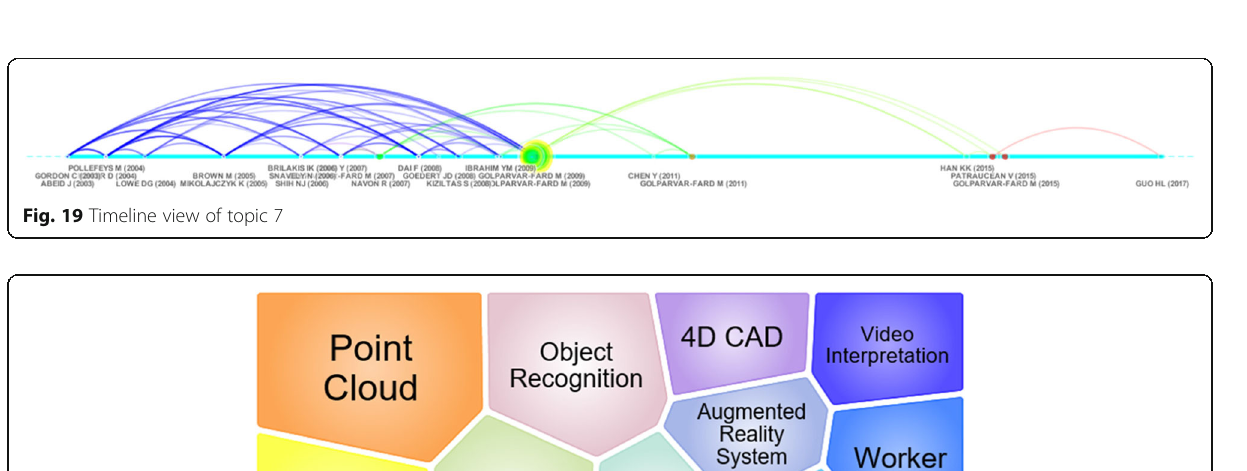
Fig. 18 Foam tree view of keywords in cluster #5